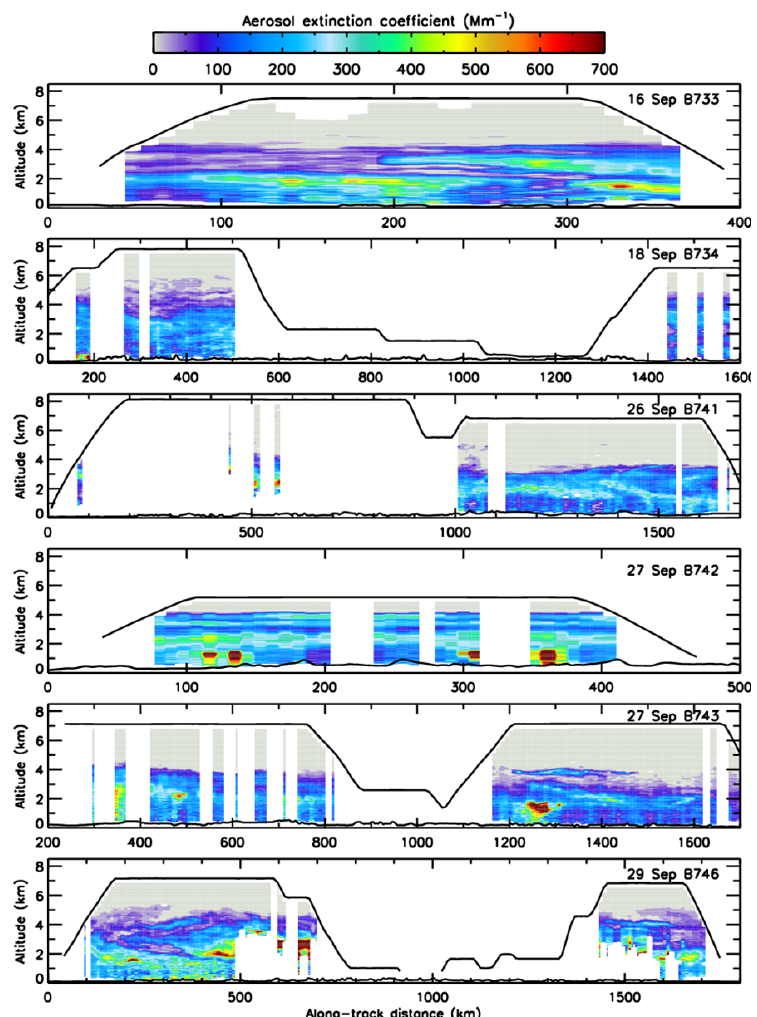
Figure 10. Cross sections of the aerosol extinction at 355nm coefficient determined from the lidar for the six research flights with a 1min integration time. The black lines indicate the aircraft altitude and the surface elevation from a digital elevation model,